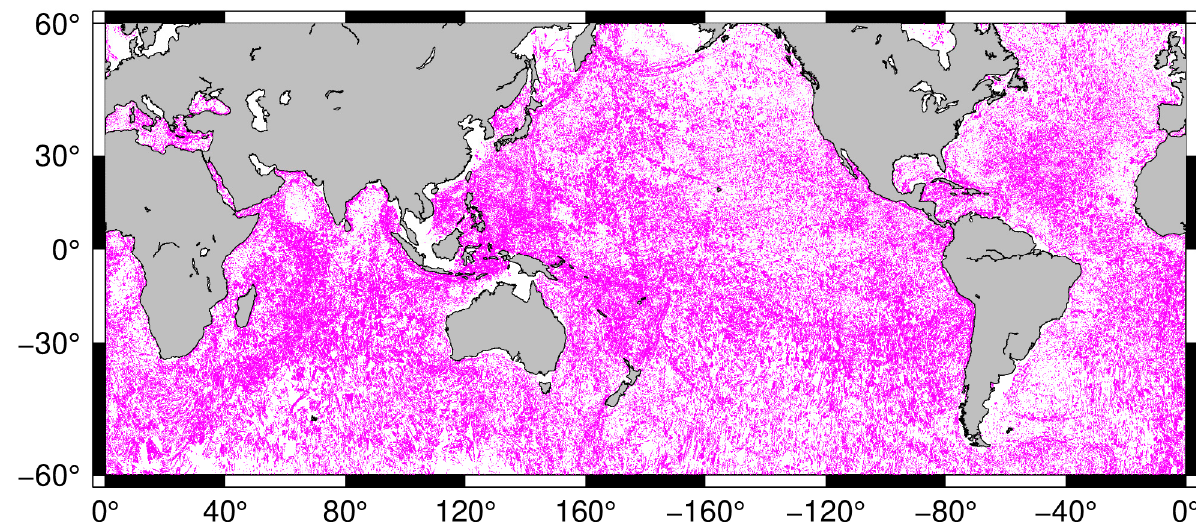
Figure 9. Positions of the points with an improvement greater than 50 m.